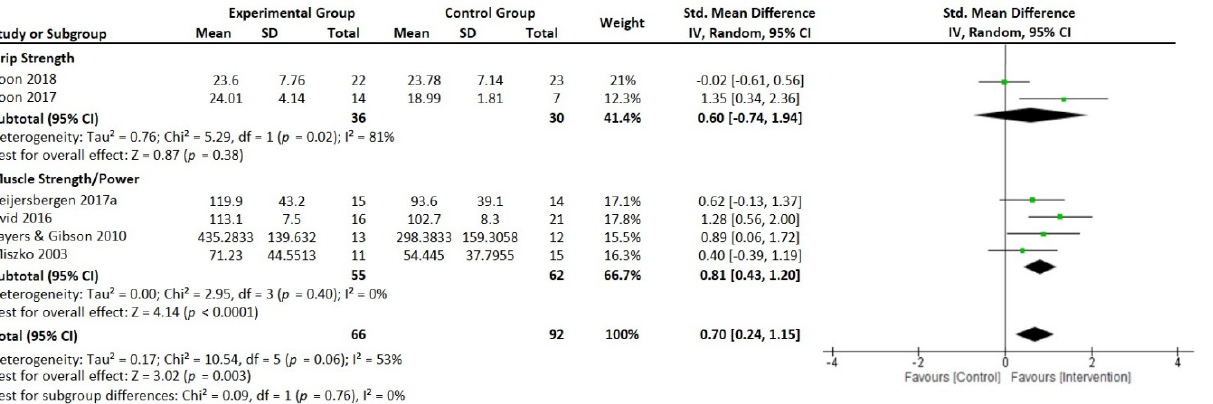
Figure 2. Forest plot presenting standardized mean difference and 95% confidence intervals from studies reporting high-speed resistance-training-induced changes in cognitive function between the intervention groups and the control groups. IV, independent variable; CI, confidence interval; SMD, standardized mean difference; FAB, frontal assessment battery; MMSE, mini-mental state examination [60,63,66,67].